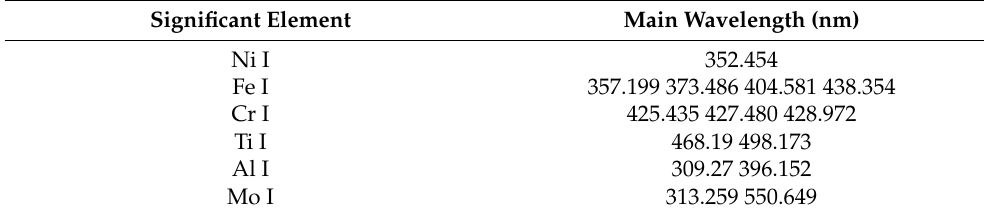
Table 2. Selection of characteristic spectral lines [34].